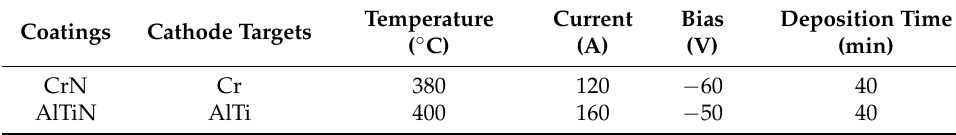
Table 1. Deposition parameters of CrN and AlTiN coatings.